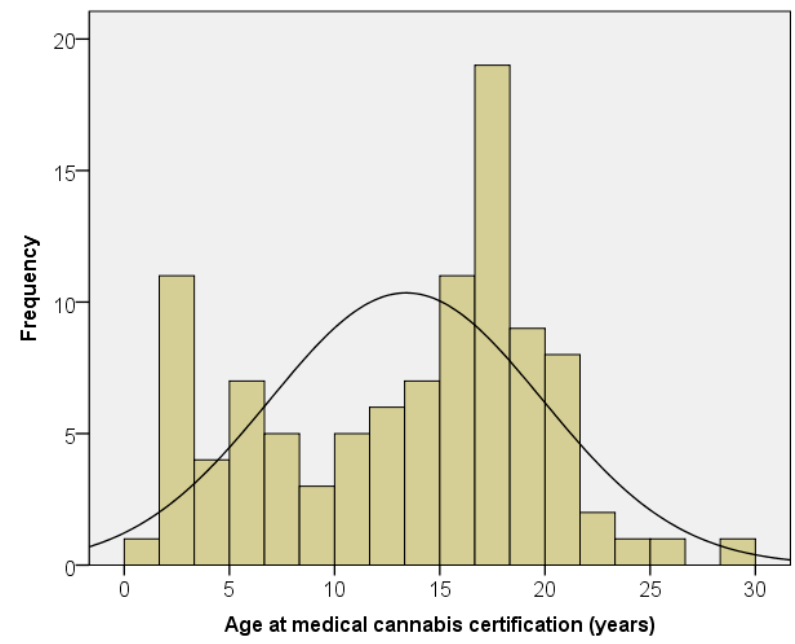
Figure 1. Age at medical cannabis certification.